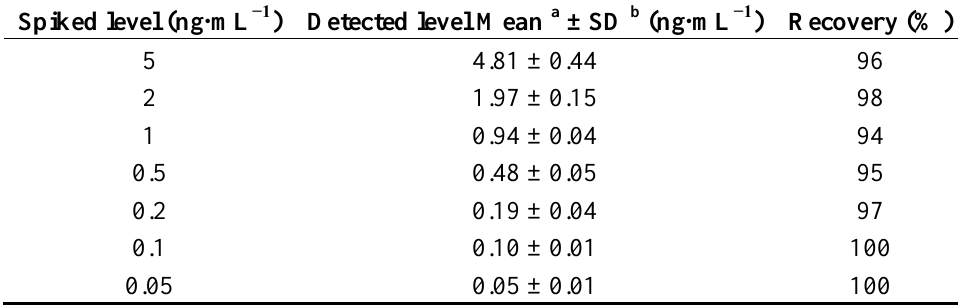
Table 1. Determination of Pb 2+ in spiked tap